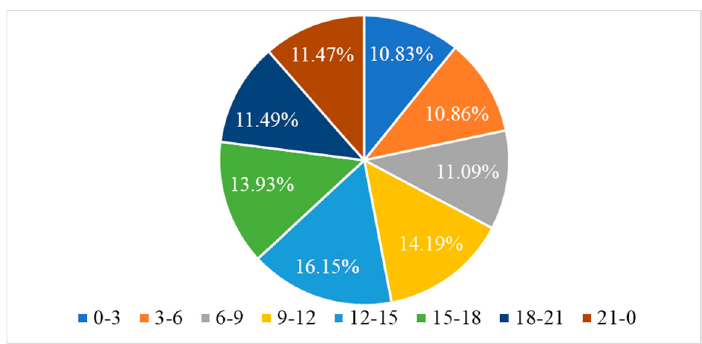
Figure 6. Energy consumption classification per hour of the day.